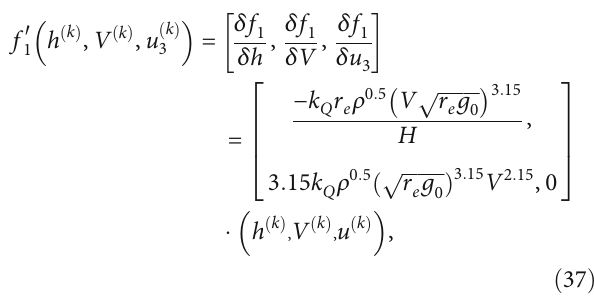
Figure 9: Comparison of control variables